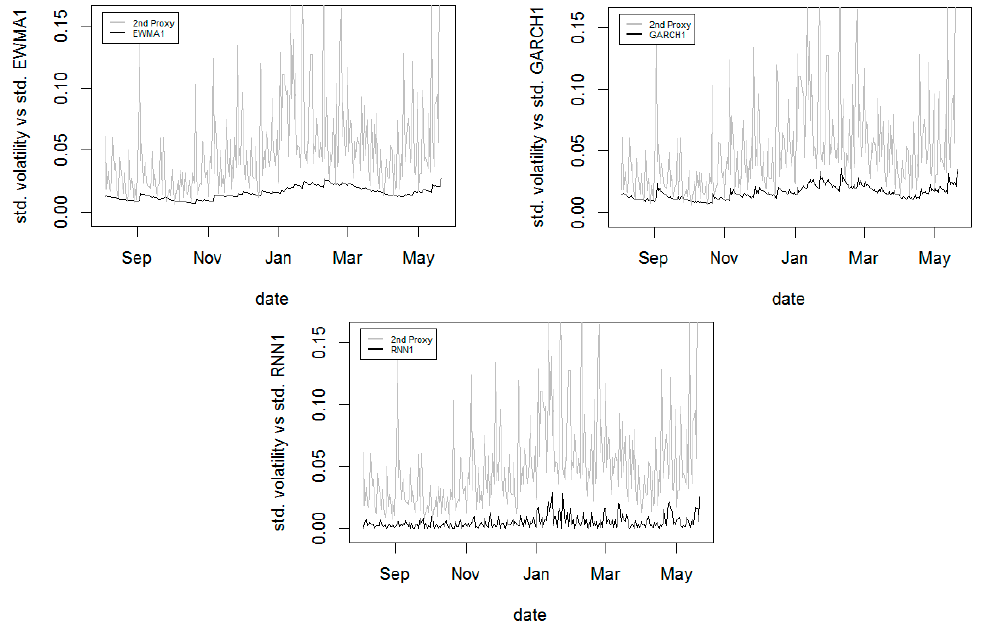
Figure 5. Out of sample standard deviation of realized volatility (2nd proxy) vs standard deviation of one day ahead volatility forecasting of EWMA, GARCH, and RNN model. EWMA1, GARCH1, and RNN1 denote the one day ahead forecasting of each model.